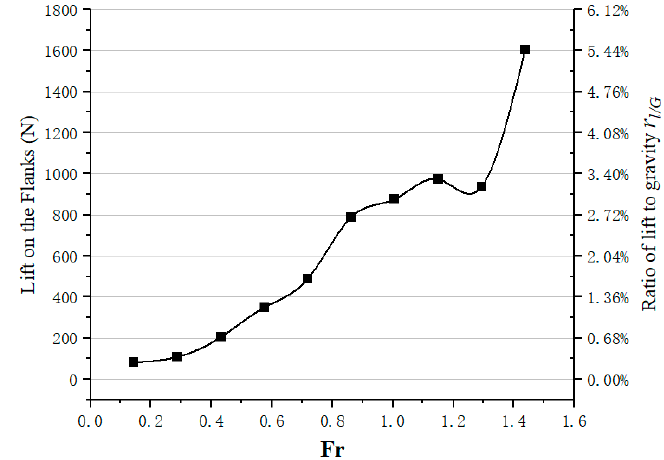
Figure 13. Lift force and lift-to-gravity ratio.